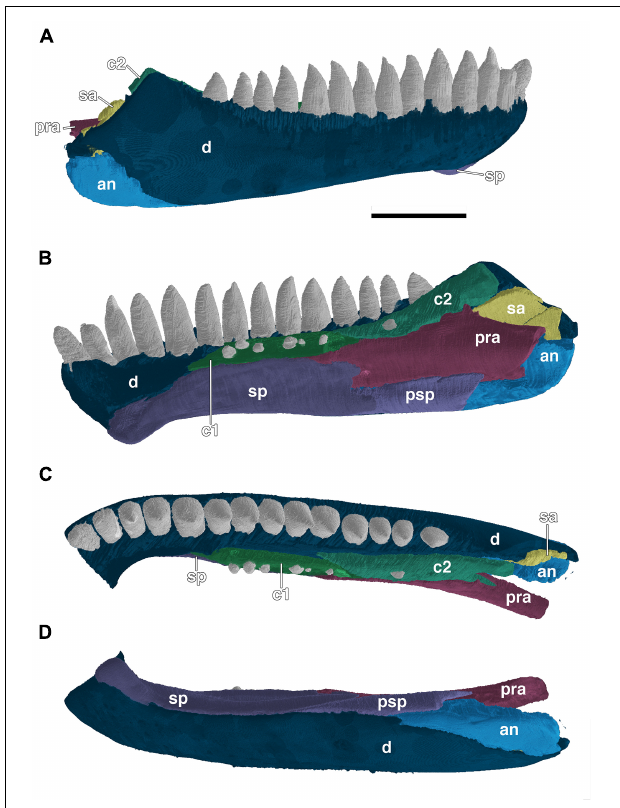
FIGURE 3 | The partial right mandible of Nannaroter mckinziei , OMNH 73107, reconstructed from CT data. (A) , Lateral view, (B) medial view, (C) , dorsal view, and (D) ventral view. a, angular; c1, anterior coronoid; c2, posterior coronoid; d, dentary; pra, prearticular; psp, postsplenial; sa, surangular; sp., splenial. Scale bar equals 2 mm.